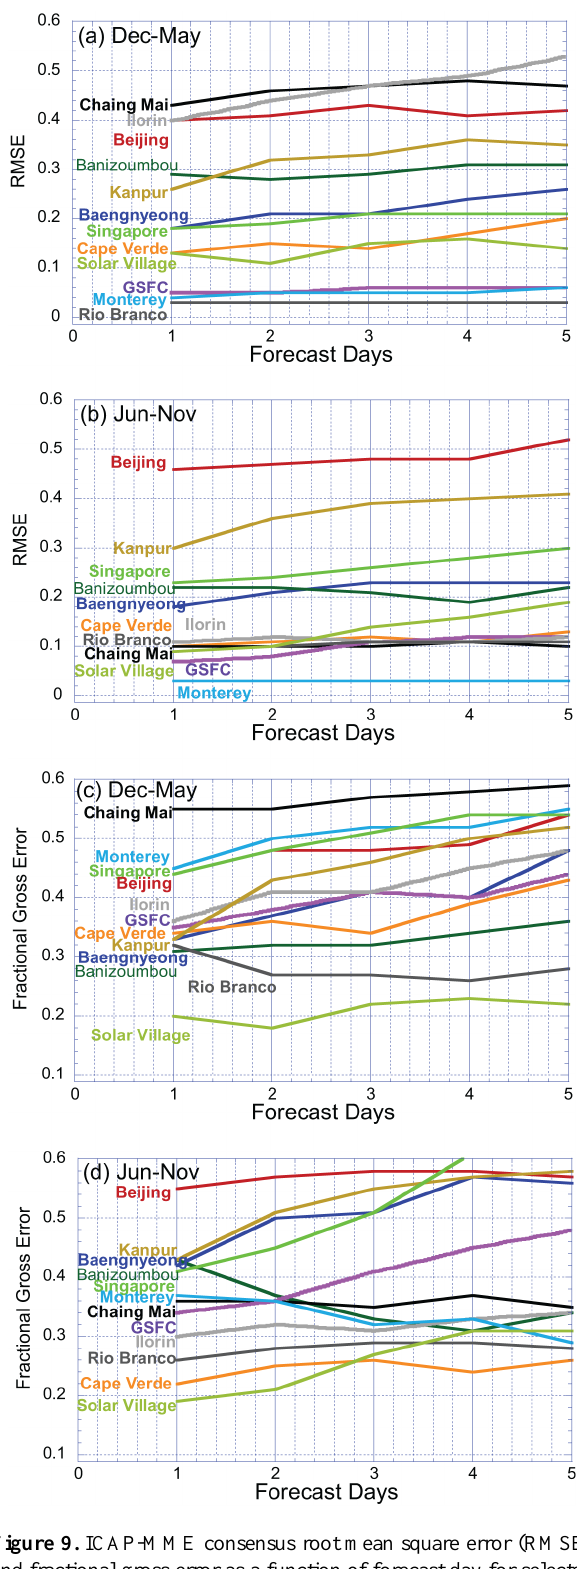
Figure 9. ICAP-MME consensus root mean square error (RMSE) and fractional gross error as a function of forecast day for selected AERONET sites shown in Fig.